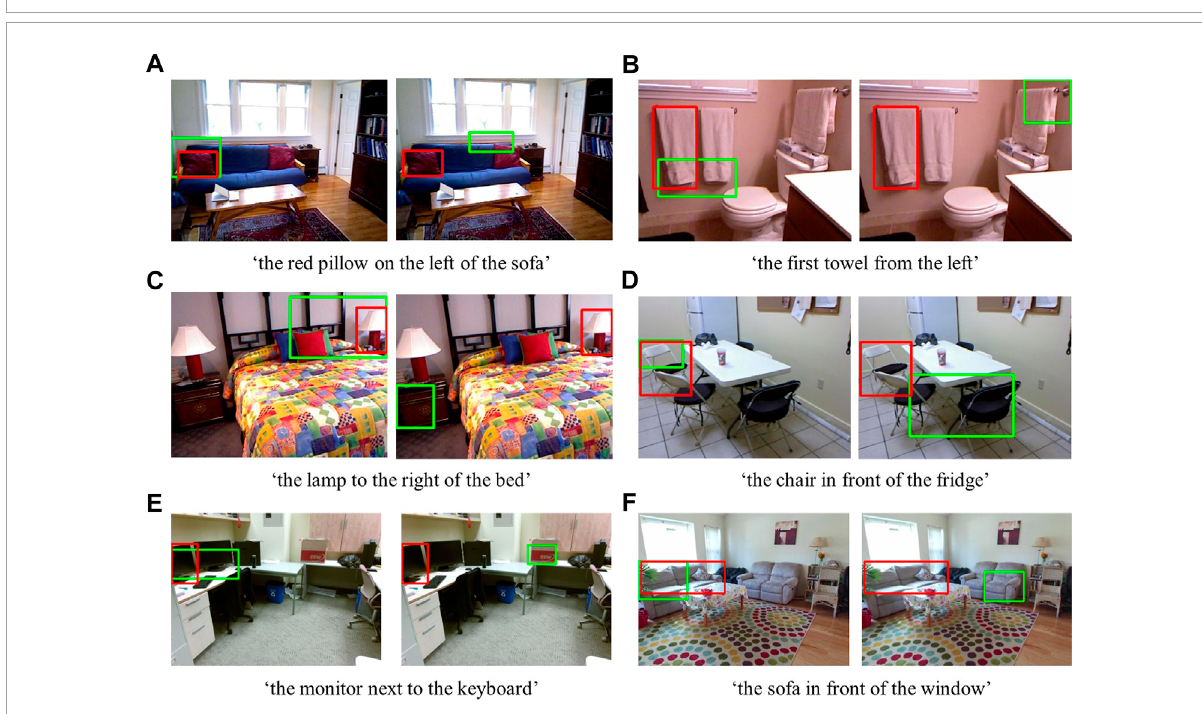
FIGURE 10 Examples from the depth independent (A,B, C) and depth dependent (D,E, F) SUN RGB-D dataset. The red bounding boxes show the target objects (ground truth), and the green boxes show the first candidates from the Grad-CAM RGB-D method (on the left) and the Grad-CAM RGB method (on the right) suggested for the given expressions. Best viewed in